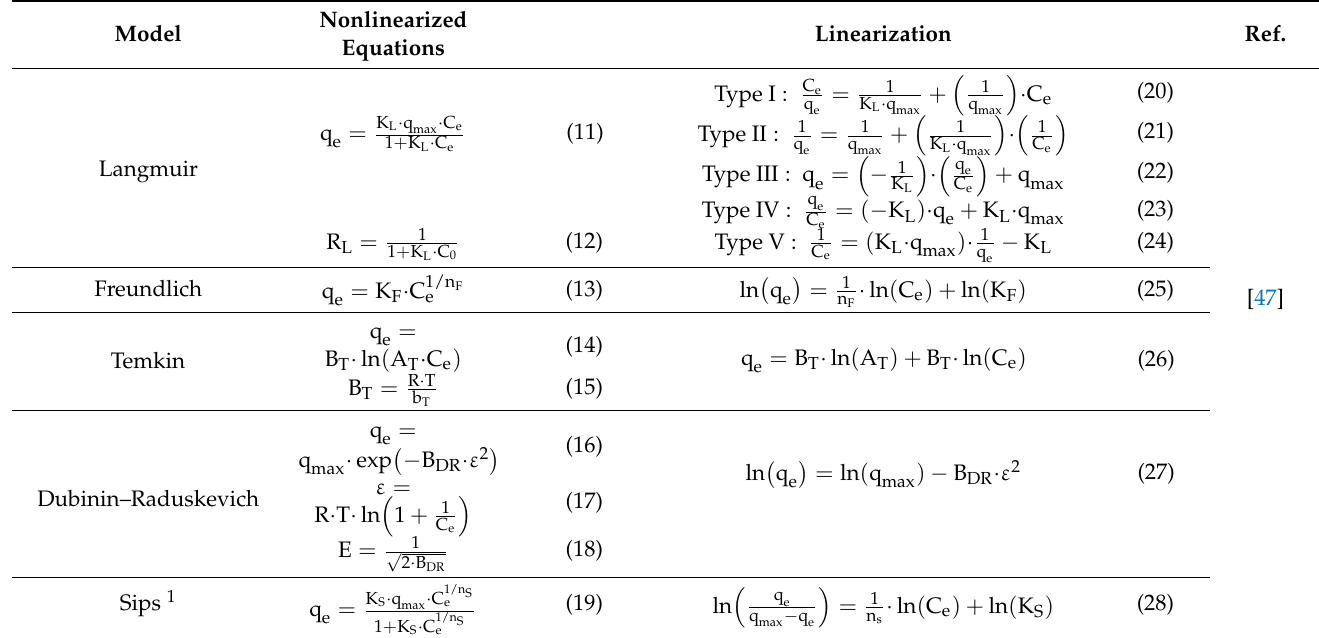
Table 2. The nonlinear and linearized equations of the analyzed isotherm